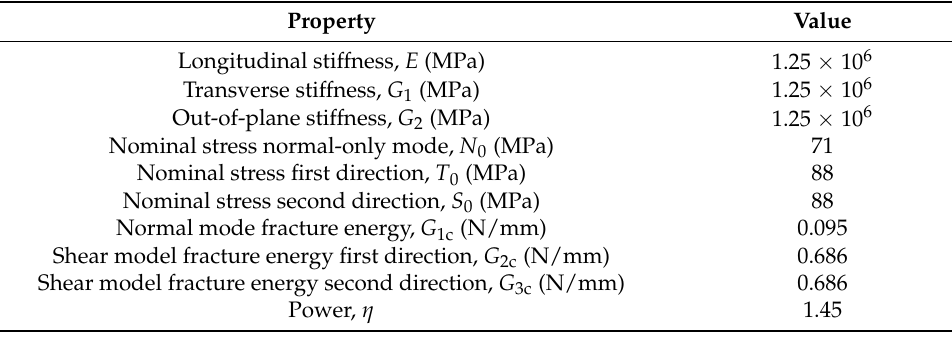
Table 2. Description of the properties of the cohesive